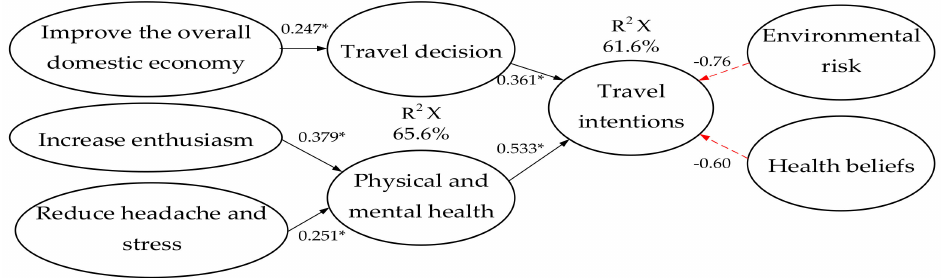
Figure 2. Results of the regression analysis of travel decisions, environmental risk perceptions, health beliefs, and physical and mental health perceptions on travel intentions. * p <